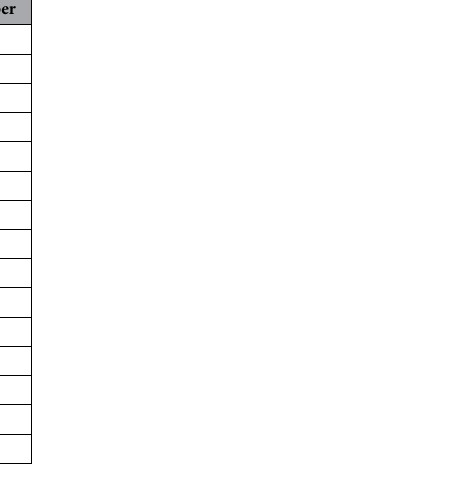
Table 2. Concrete mix design (kg/m 3